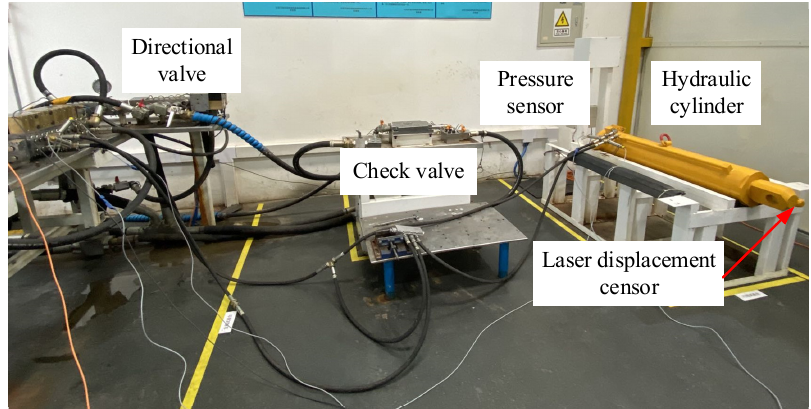
Figure 11. Hydraulic schematic diagram of the test system.